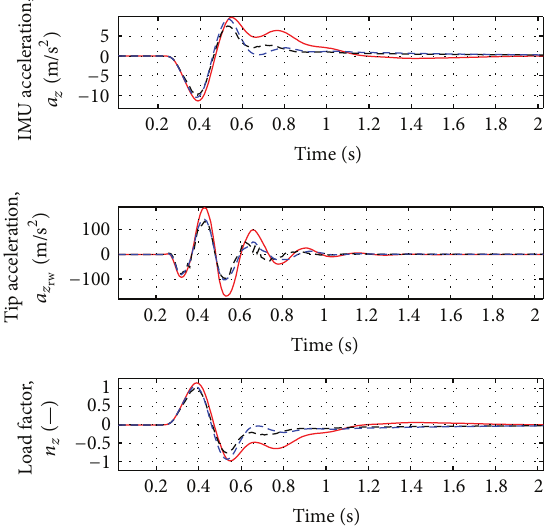
Figure 7: Variation of acceleration and load factor for nominal case with ideal and real actuator. Red solid line: open loop. Black dotted line: ideal actuator model. Blue dotted line: real actuator